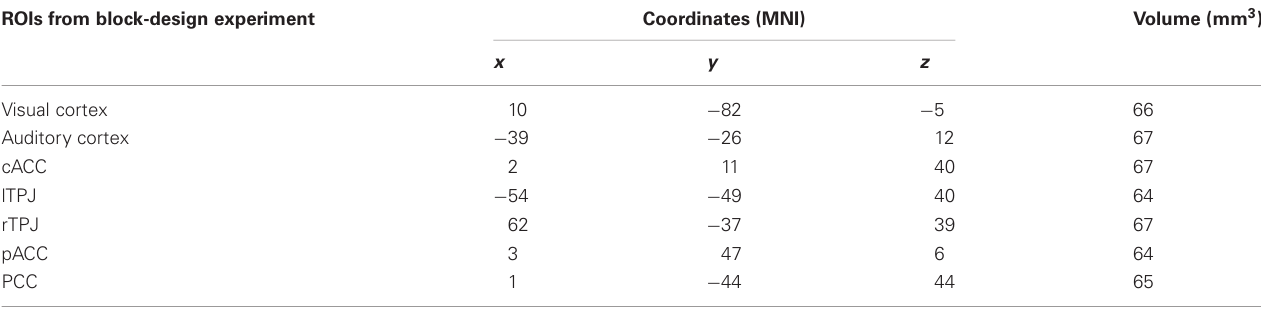
Table A1 | ROIs defined based on the EO > EC (block-design experiment). ROIs from block-design experiment